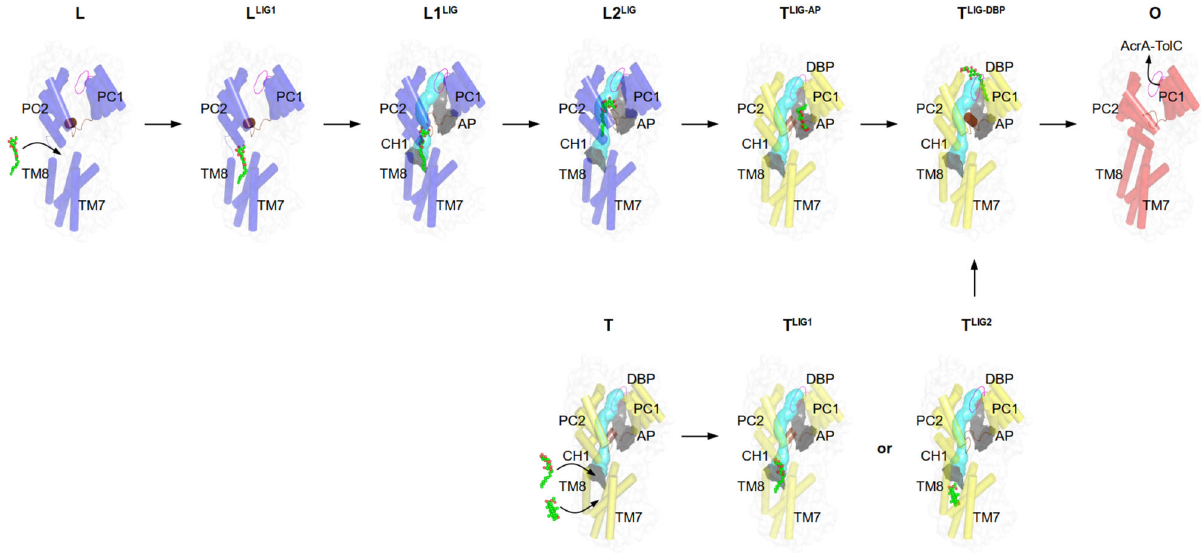
Fig. 3 Proposed drug transport mechanism via CH1 and the TM8/PC2 pathway during L, T, and O functional rotation based on crystal structures. Dodecyl β -D-maltoside (DDM) and fusidic acid (FUA) are depicted as spheres (carbon, green; oxygen, red). The switch loop (magenta) and c-loop (brown) conformations are indicated in every protomer (AP access pocket, DBP deep binding pocket, CH1 channel 1). For further discussion on the mechanism see main text and Supplementary Note 1.7. PDB IDs of the displayed protomer structures: L, L LIG1 , T, T LIG1 , T LIG-AP , O: 4DX5; L1 LIG : 4ZJL; L2 LIG : 6ZOA; T LIG2 : 6ZOF; T LIG-DBP :